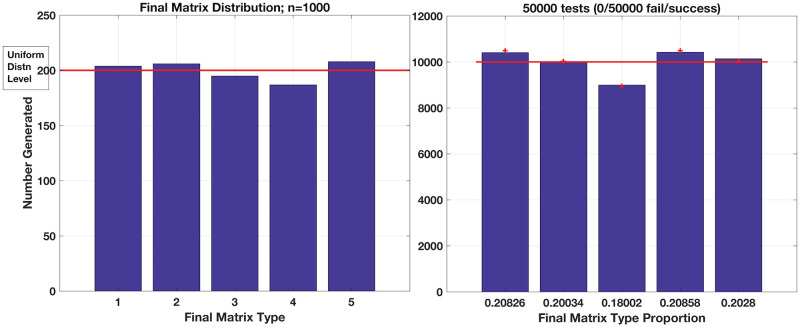
Distribution of resulting 3x3 matrices for predescribed kin and kout = [1 2 1].The 5 possible results should all emerge with identical probability if the method samples these possibilities uniformly. Testing 1000 matrices (Left Pane), we obtain roughly 1/5 or 20% for each possible matrix A(f), but only roughly. (Right Pane) Histogram of n = 50, 000 samples showing convergence to the expected—and non-uniform—distribution of final A(f) as calculated through all possible trajectories from A(0) → A(f). Red markers above each bar indicates theoretical expected values of 0.2099, 0.2006, 0.1790, 0.2099 and 0.2006 for the 5 types of A(f), respectively.